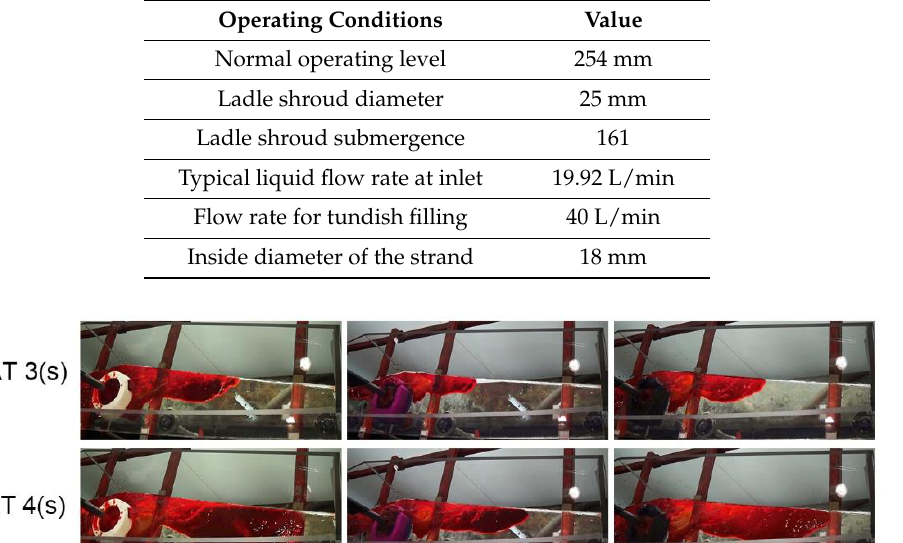
Figure 2. Dimensions of the tundish in millimeters at 1/3 scale of the actual one. Table 1. Operating conditions of the tundish (1/3rd scale) under steady and unsteady conditions (startup of a casting sequence).